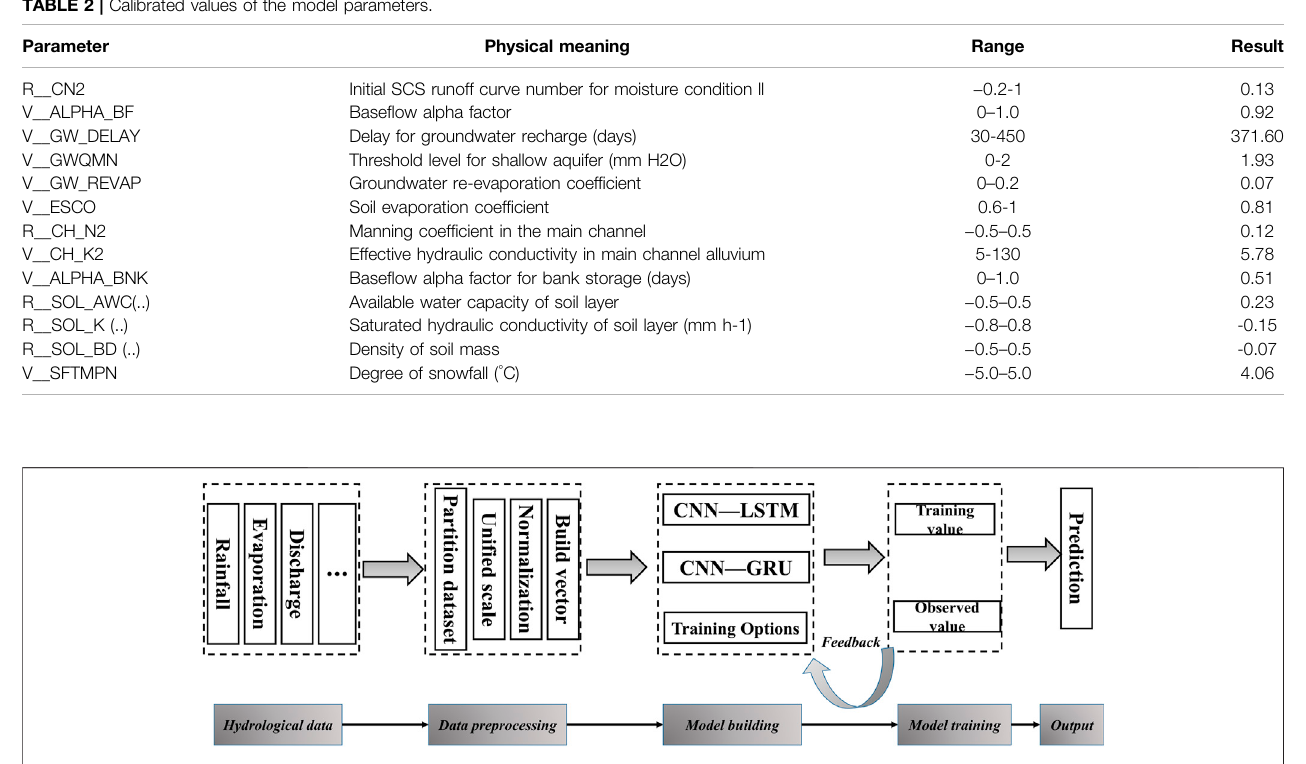
FIGURE 5 | Technology roadmap of deep learning models for rainfall-runoff simulation and